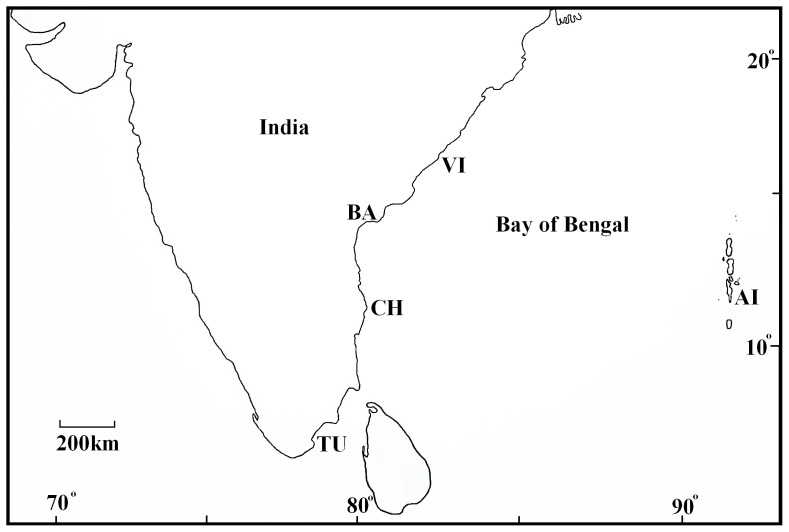
Map showing areas from which P. monodon were sampled.
AI, CH, TU and VI represent catch areas covered by landing centres in the Andaman Islands, Chennai, Tuticorin and Vishakhapatnam respectively. BA represents the Bapatla location where shrimp that survived a severe WSSV infection were sampled. Approximate degrees of latitude and longitude are shown.